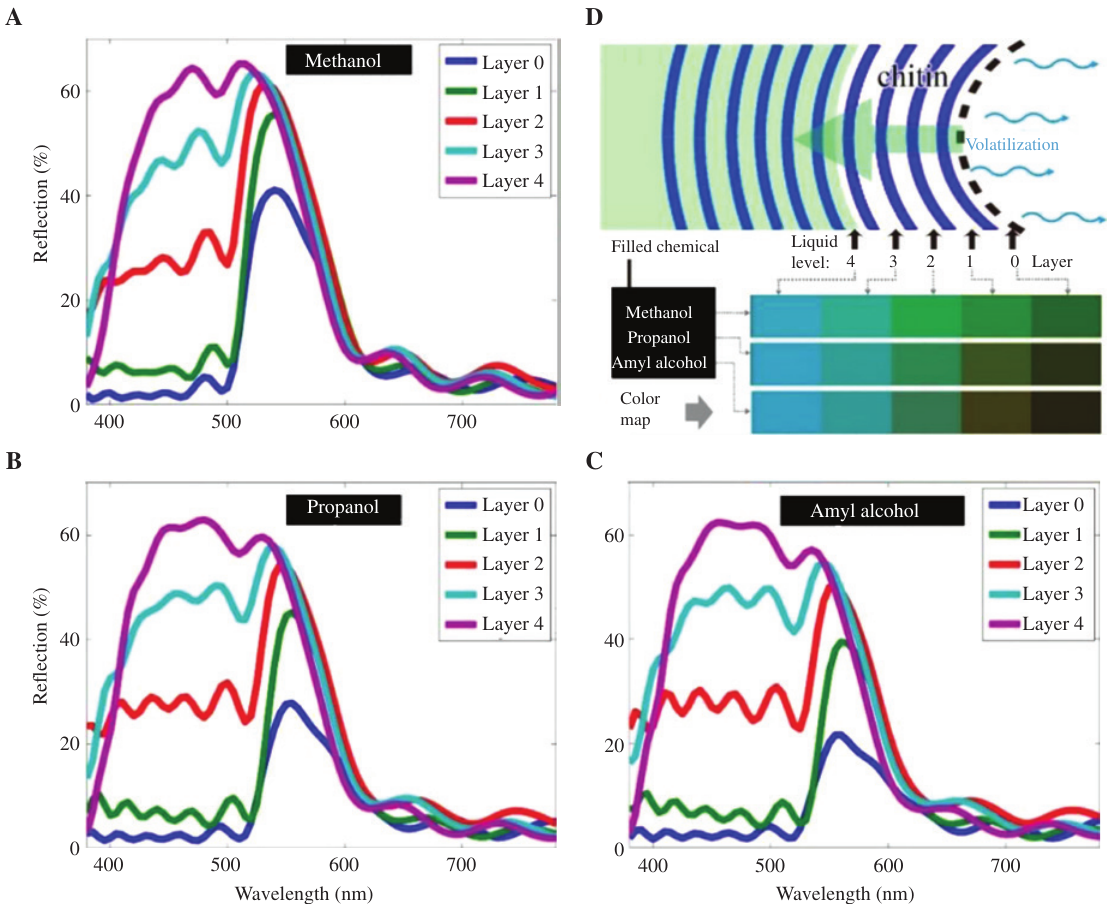
Figure 7: Computed reflectivity spectra show the effect of different filled chemicals: (A) methanol (refractive index = 1.33), (B) propanol (refractive index = 1.386), and (C) amyl alcohol (refractive index = 1.411). Layers 0–4: the liquid level of ethanol shown in (D). (D) Schematic plot of the model shows the volatilization of the ethanol, the liquid levels are labeled as 0 to 4. The color map with different filled chemicals was calculated from the corresponding